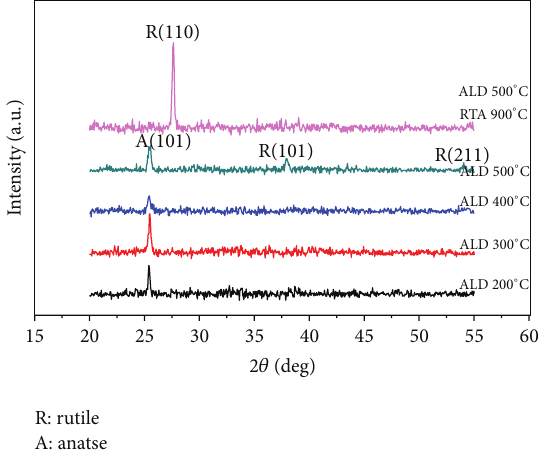
Figure 4: XRD patterns of TiO 2 thin films deposited at 200 ∘ C, 300 ∘ C, 400 ∘ C, 500 ∘ C, and RTA 900 ∘ C.